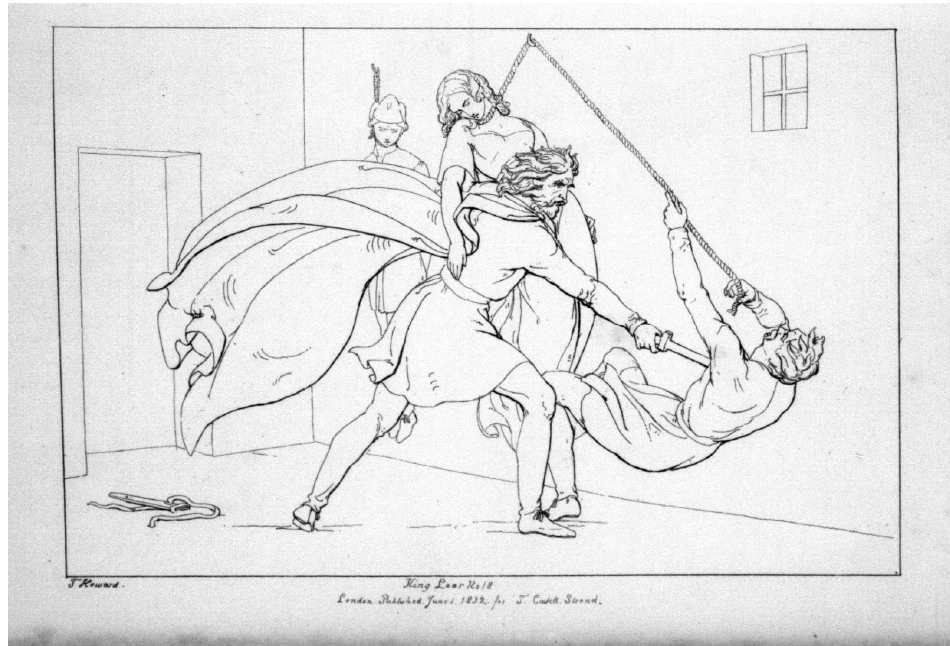
Figure 5. Engraving by Frank Howard, in The Spirit of the plays of Shakspeare [sic], ed. Frank Howard, London, Cadell, 1833, 5 vols.,